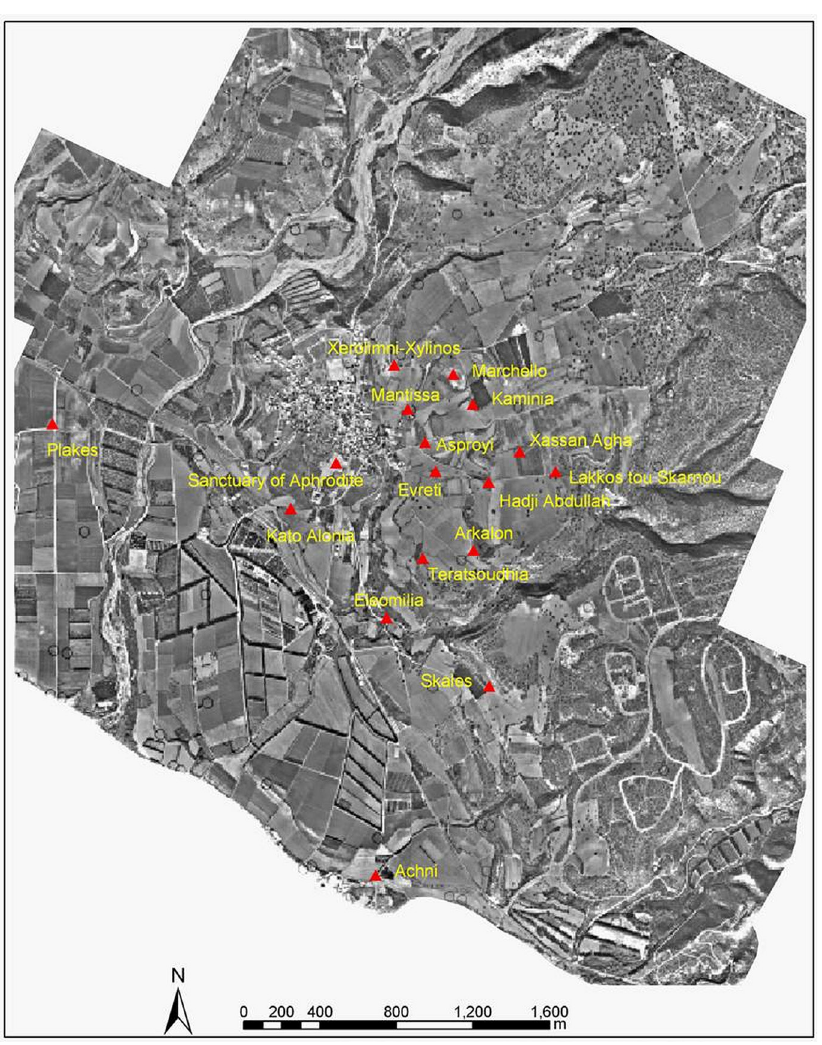
Figure 7. Orthophoto map with LBA and Iron Age archaeological sites around the sanctuary. Drafted by A. Sarris (PULP@).